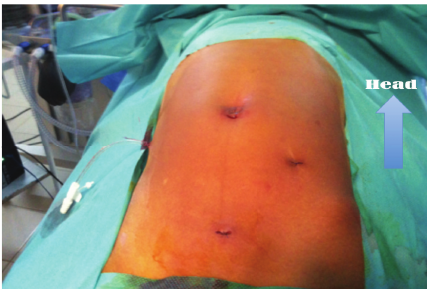
Figure 5: Appendicular peritonitis operated laparoscopically and